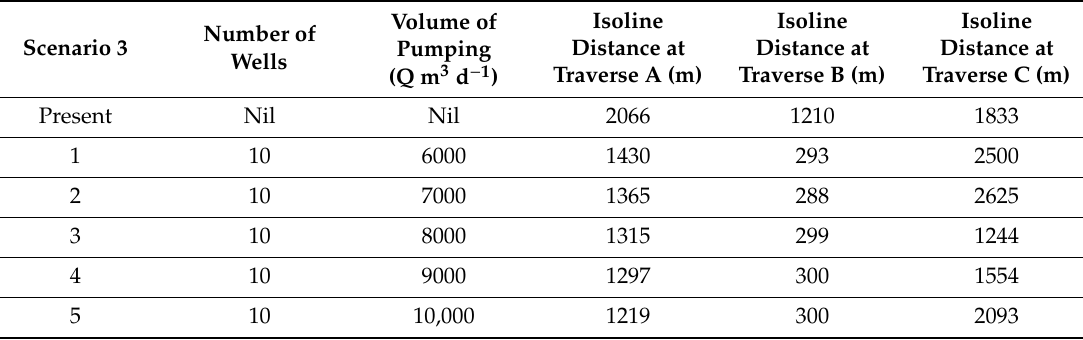
Table 5. Distance of 15,000 mg L − 1 Isosalinity Contour along Transects A, B and C using a Constant Number of Wells (10), Constant Distance from the Coastline (1500 m) and Varying Groundwater Pumping (600–1000 m 3 d − 1 per well).